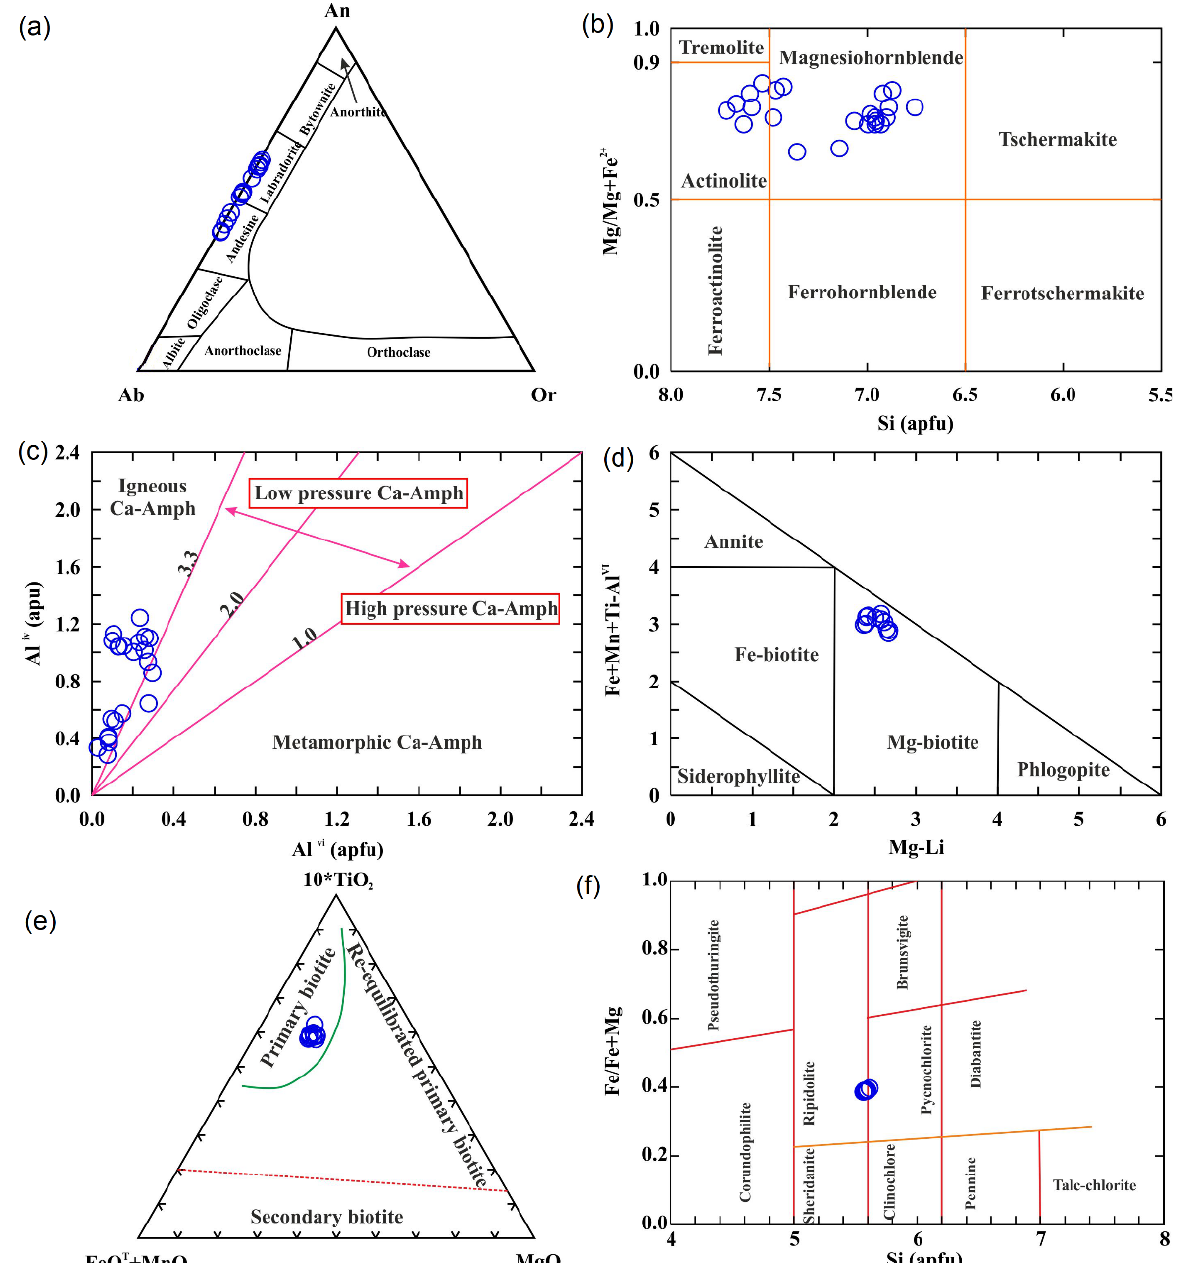
Figure 4. ( a ) Classification of plagioclase on Ab-Or-An ternary diagram; ( b ) Mg/(Mg + Fe 2+ ) vs. Si classification diagram for amphiboles [39]; ( c ) variation of Al iv /Al vi ratios in Ca-amphiboles of igneous and metamorphic (low- and high-pressure) origin [40]; ( d ) chemical composition of biotites based on (Fe + Mn + Ti − Al vi ) vs. (Mg − Li) diagram [41] ; ( e ) the (FeO T + MnO) − (10 × TiO 2 ) − MgO ternary diagram of Nachit et al. [35], showing the magmatic affinity of the analyzed biotite; and ( f ) plot of chlorite composition in the classification diagram of Hey [42] .